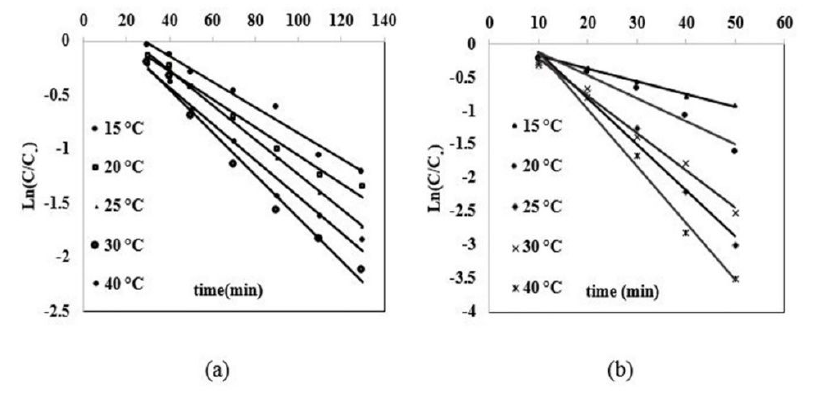
Fig. 6. Fitting first-order model to the experimental perchlorate removal rate (a)